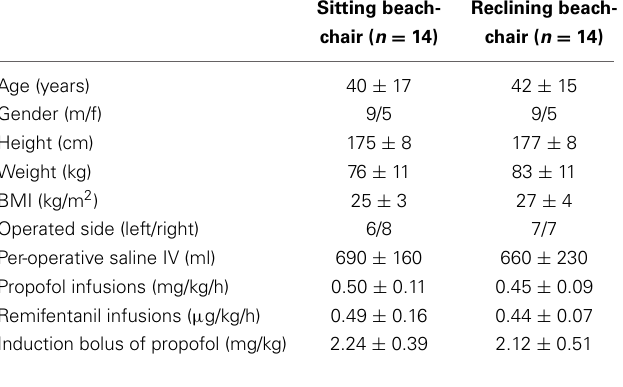
Table 1 | Clinical characteristics of the study population.